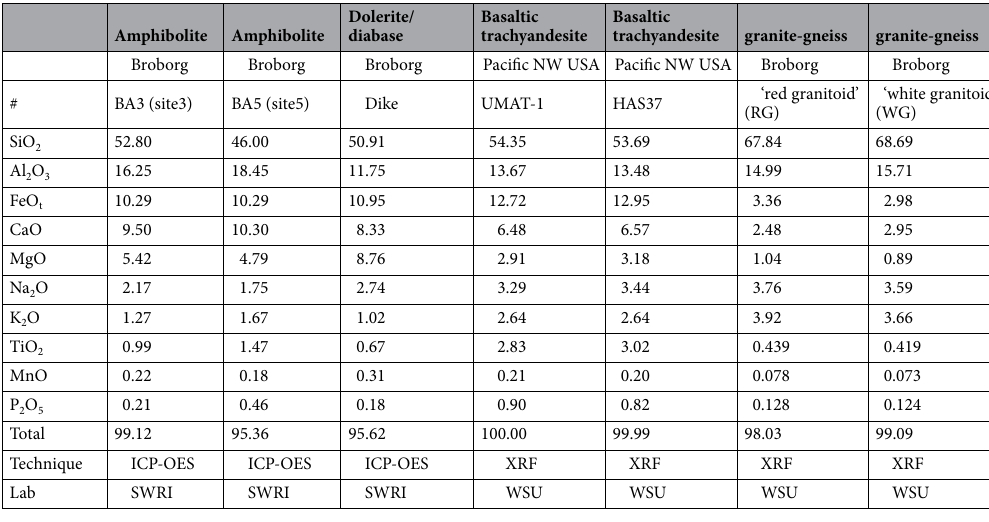
Table 3. Major element compositions of selected source rocks for melting experiments (wt%). Note that FeO t is FeO total, and redox conditions are not assumed. Additional rock compositions in Table S3. Chemical analysis was performed with X-ray fluorescence (XRF) or Inductively Coupled Plasma-Optical Emission Spectroscopy